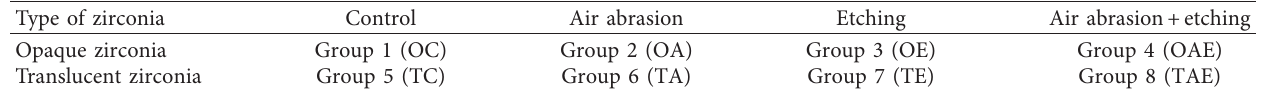
Table 2: Total specimens divided into 8 groups with 10 specimens